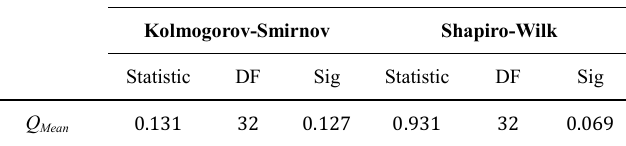
Table 4. Tests of Normality